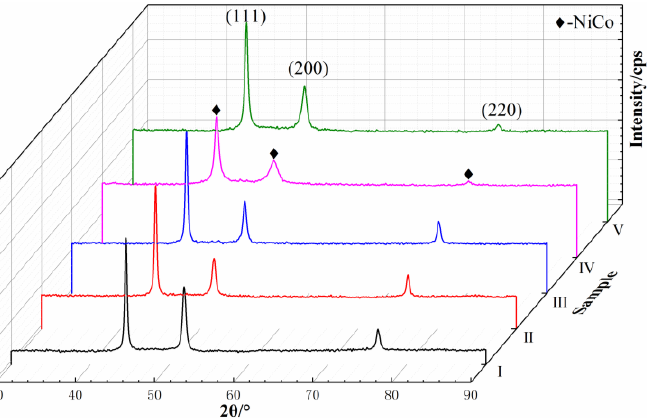
Figure 6. XRD Patterns curves of alloy coated samples prepared under different external fields.